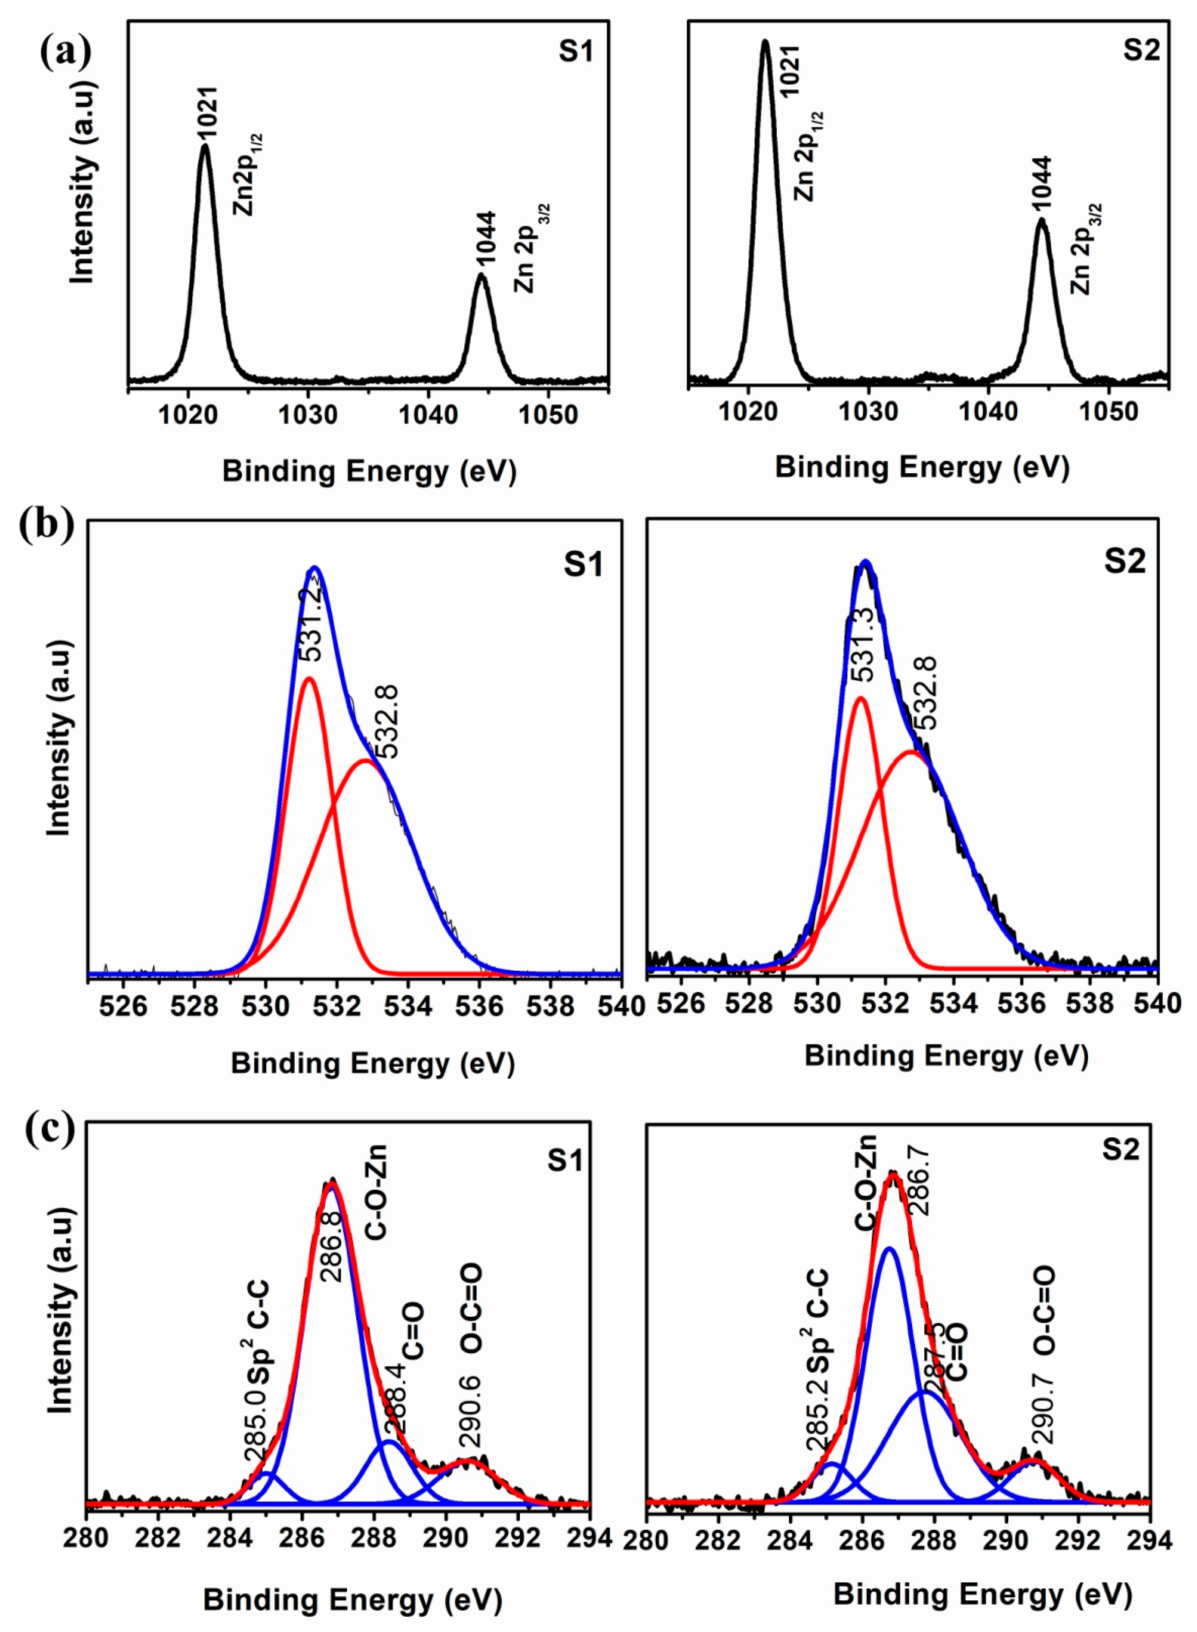
Figure 4. XPS spectrum of ( a ) Zn 2p ( b ) O 1s and ( c ) C 1s peak of the ZnO/graphene